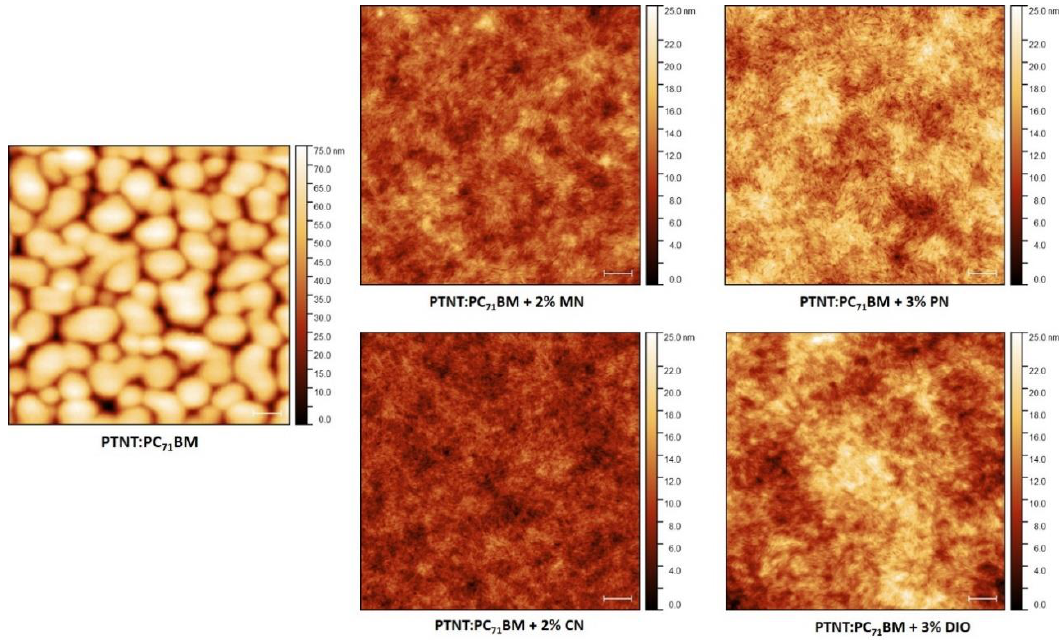
Figure 4. Atomic force microscopy (AFM) images (5 µ m × 5 µ m) showing the surface topography of PTNT:PC 71 BM (2:3) blend from o -xylene with different solvent additives at room temperature. The scale bar is 500 nm.